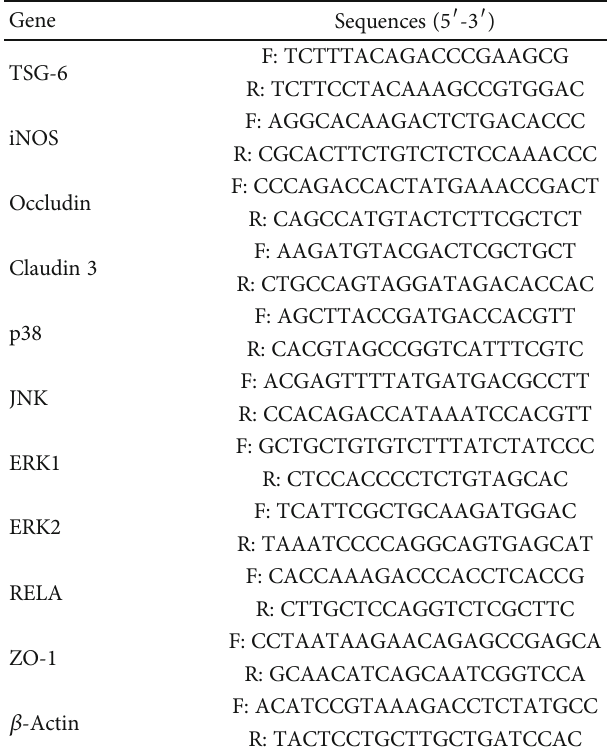
Table 1: Primer sequences. Gene Sequences (5 ′ -3 ′